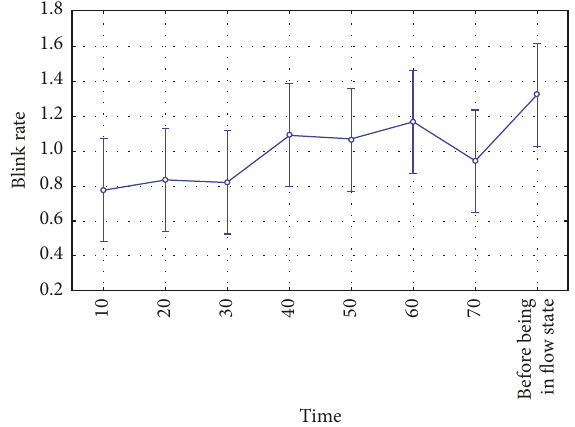
Figure 5: Blink rate result of flow group.